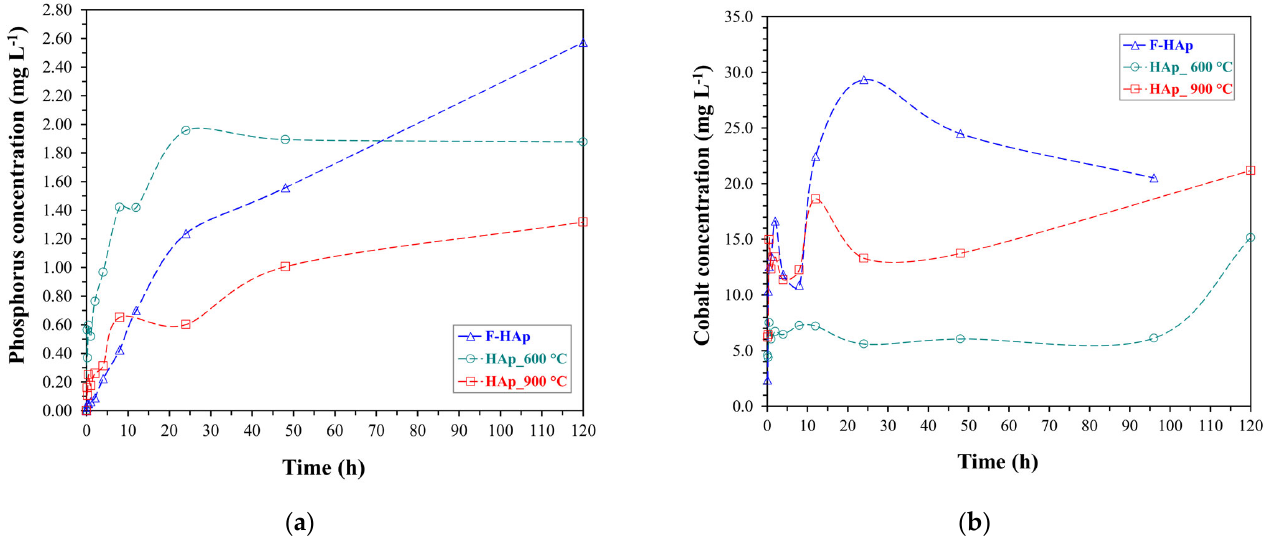
Figure 12. ( a ) Phosphorus and ( b ) Cobalt release assays by extraction in citric acid medium.